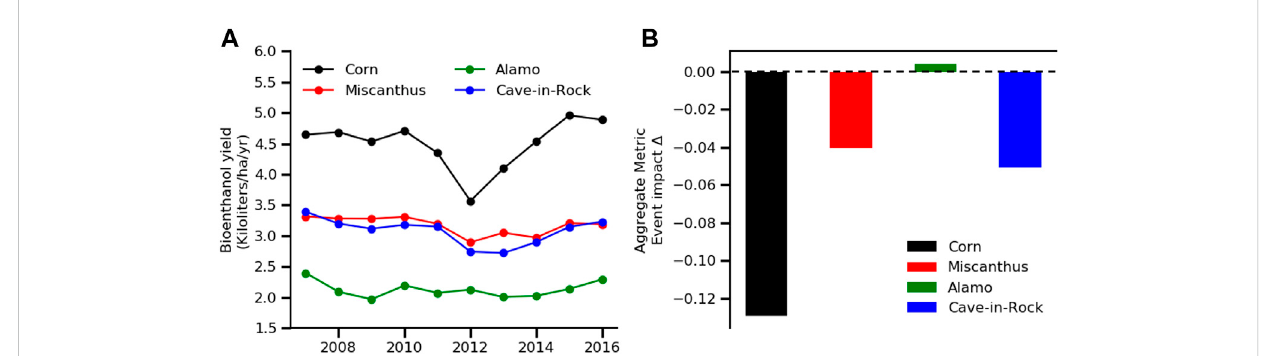
FIGURE 6 The impact 2012 Midwest drought and heat on (A) bioethanol yield for corn (grain plus 30% of stover harvested) and three bioenergy crops (Miscanthus, Alamo, and Cave-in-Rock) from 2007 to 2016. (B) Drought impact metrics in 2012 (Eq. 1 Vörösmarty et al., 2022, and also see Appendix A) are expressed as bar